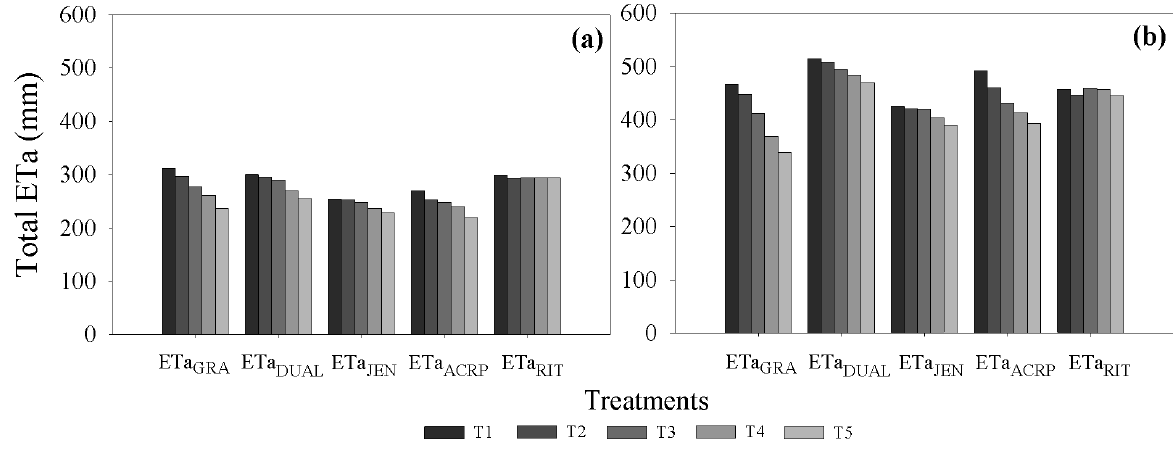
Figure 2. Total actual evapotranspiration observed (ETa ) and estimated by the models FAO56 Dual (ETa GRA Jensen and Heermann (ETa ), AquaCrop (ETa ) and Ritchie (ETa ) of soybean crop calculated for the treatments JEN ACRP RIT [T1: water available in the soil (AW) of the 80-100%; T2: 60-80% AW; T3: 40-60% AW; T4: 20-40% AW and T5: 0-20% AW)] in the winter (a) and summer (b)